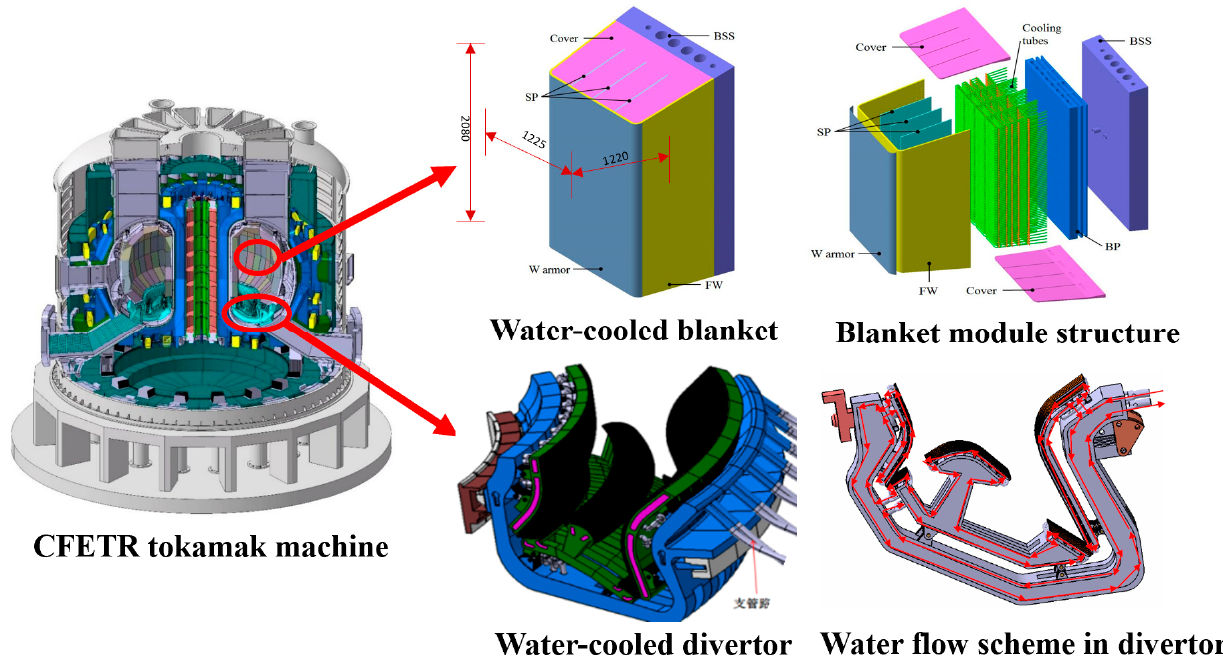
Figure 1. Water-cooled blanket and water-cooled divertor of CFETR. Table 1. Event categories of CFETR.